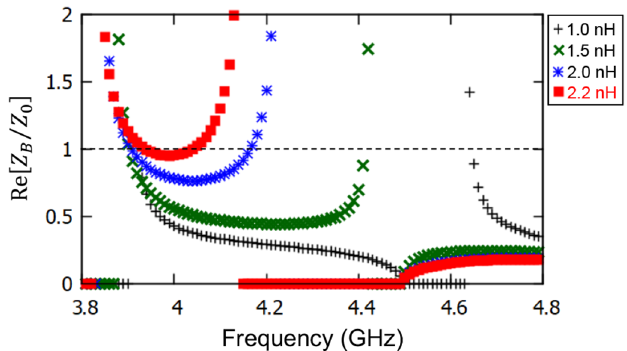
Fig. 5. Extracted real part of the effective permittivity for the composite structure as a function of the lumped inductance L .